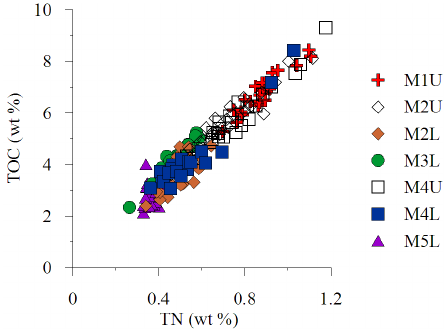
Figure 5. Total organic carbon (TOC) versus total nitrogen (TN) content for all ocean sites,